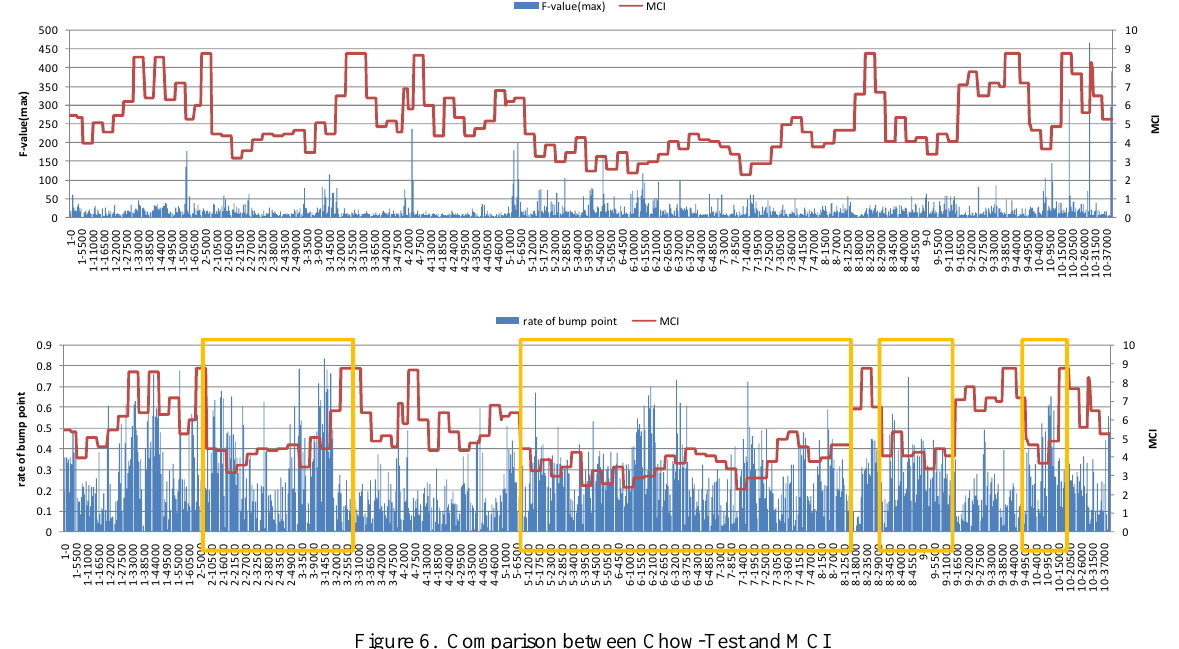
Figure 5. Result(3)